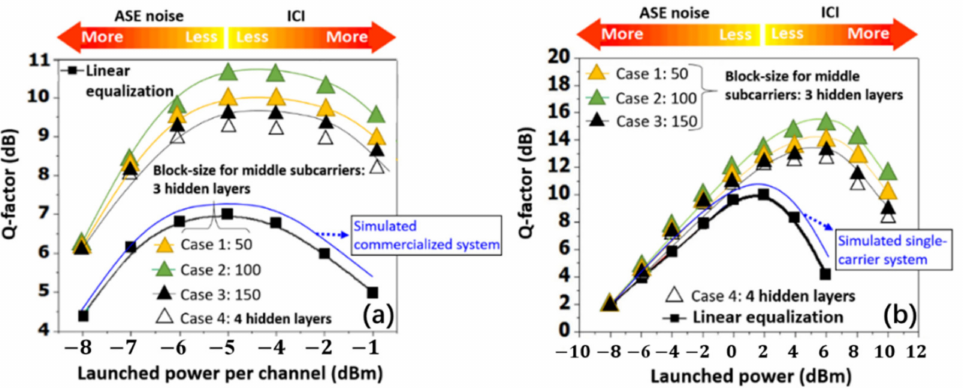
Figure 27. Transmission performance of MIMO equalizer in different cases. ( a ) WDM QPSK CO-OFDM at 3200 km; ( b ) single-channel 16 QAM CO-OFDM at 2000 km.